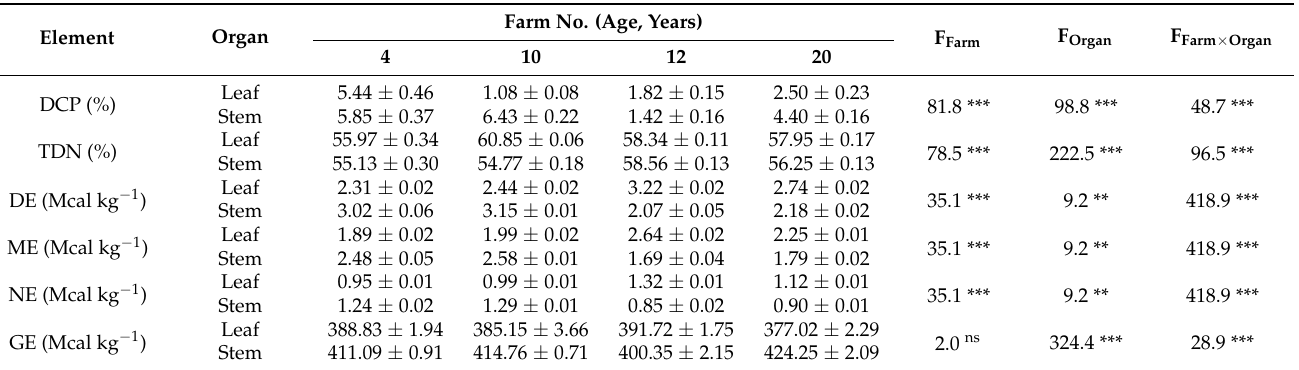
Table 5. Mean ( ± standard error, n = 6) nutritive values of Taif’s Rose populations grown in four farms in the mountainous area of Taif City in Saudi